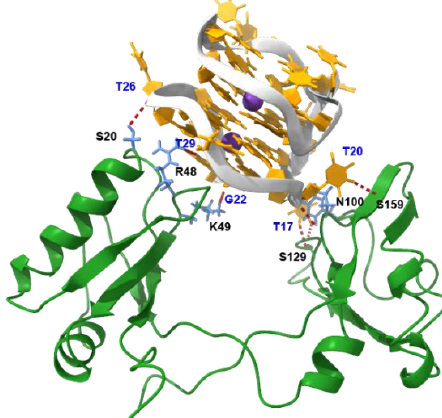
Figure 8. Final snapshot of 200 ns MD simulations of the complex AT11-L2 G4/NCL RBD1,2. G4 backbone is depicted in light grey, while nucleotides are highlighted in orange. K + is shown in purple. NCL residues that interact with AT11-L2 G4 by hydrogen bonding are highlighted in cornflower